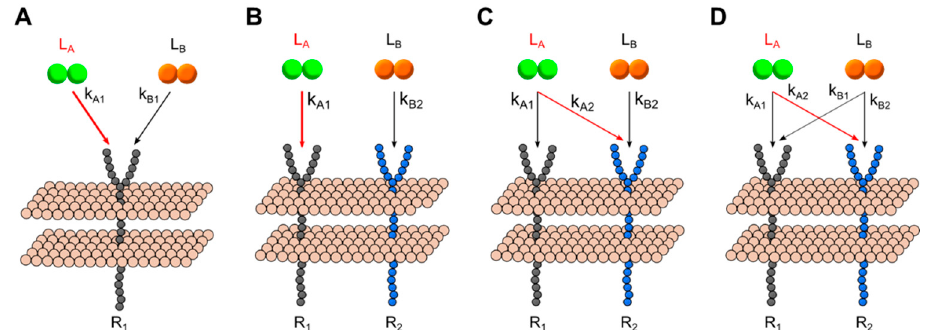
Figure 4. Generalized multi-ligand model schemes. ( A ) Two ligand, one receptor (2L1R). ( B ) Two ligand, two receptor, no overlap (2L2R0X). ( C ) Two ligand, two receptor, one overlap (2L2R1X) ( D ) Two ligand, two receptor, two overlaps (2L2R2X).